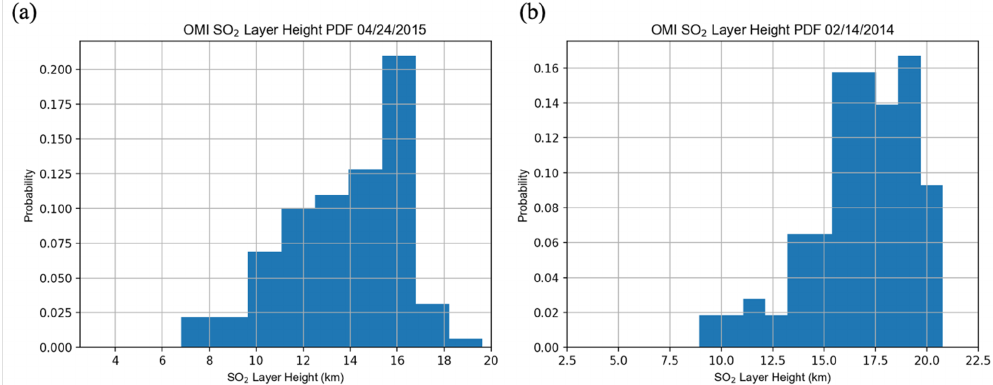
Figure 8. Probability histograms of SO 2 effective layer height retrievals for (a) the Calbuco eruption on 24 April 2015 and (b) the Kelud eruption on 14 February